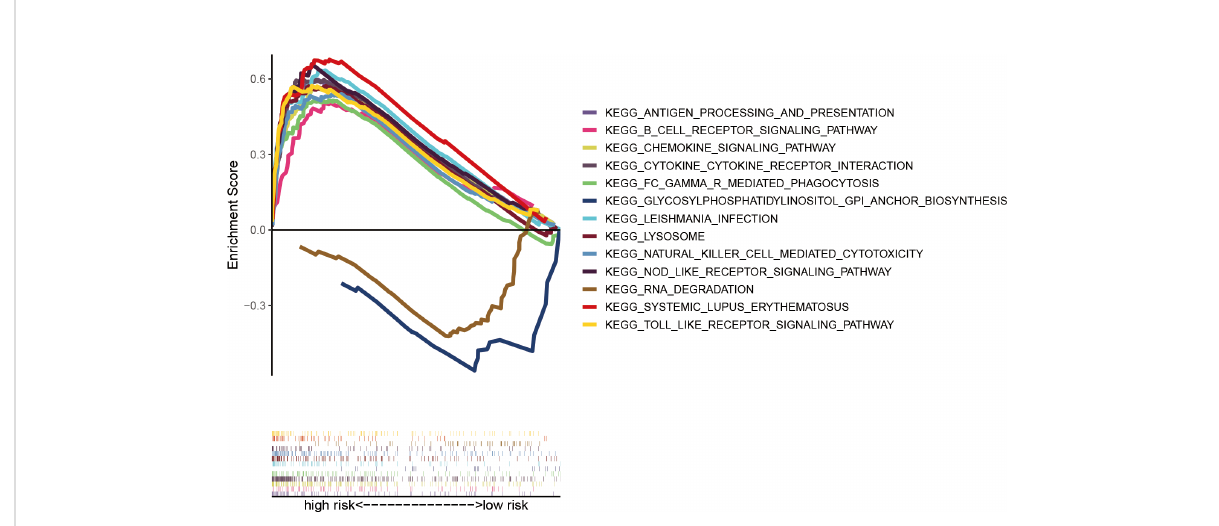
FIGURE 9 Signi fi cantly enriched KEGG pathways in AML patients with low- and high-risk groups analyzed using GSEA